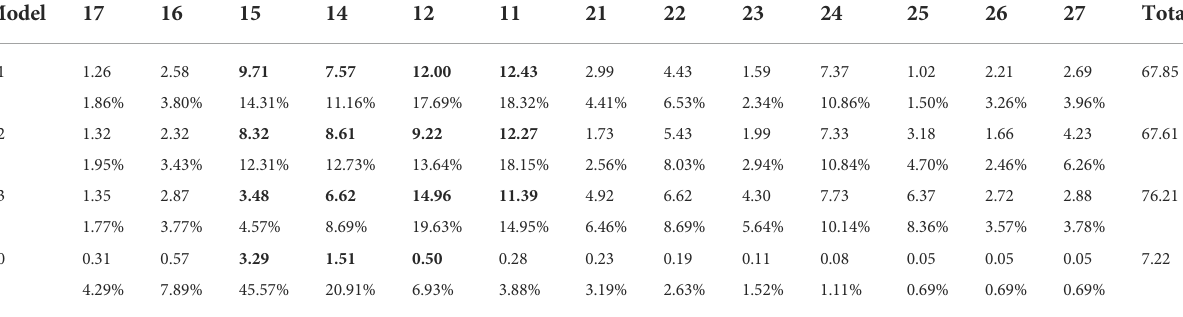
TABLE 2 Von mises stress (kPa) on PDL of anchorage teeth and corresponding percentages with different traction models used to move a maxillary right labially impacted canine located upon the fi rst premolar. Model